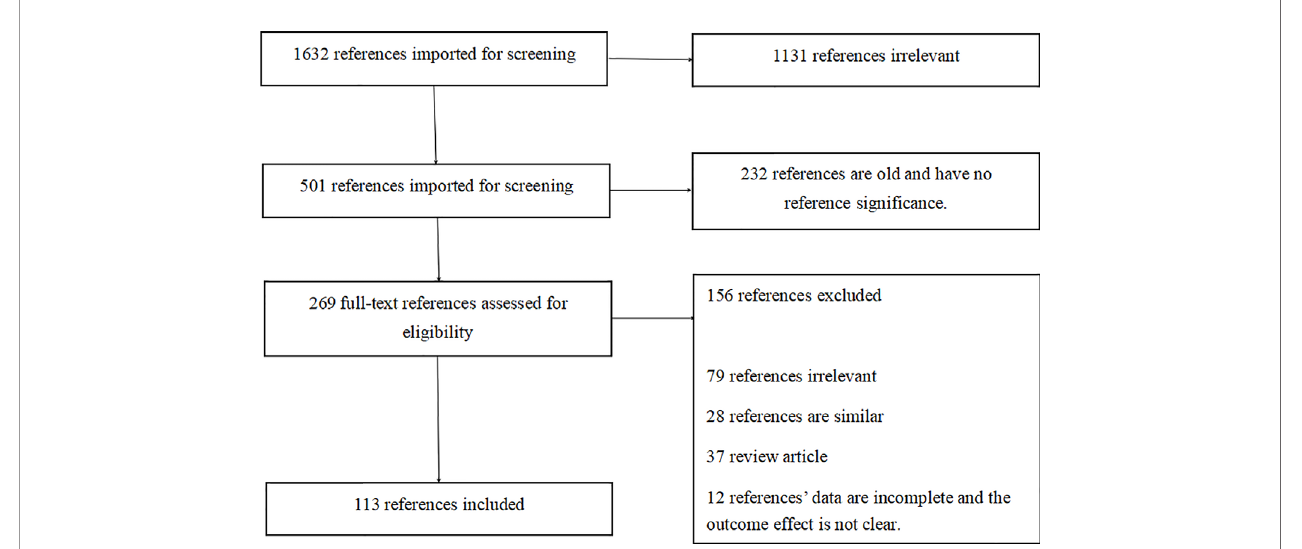
FIGURE 2 | PRISMA fl